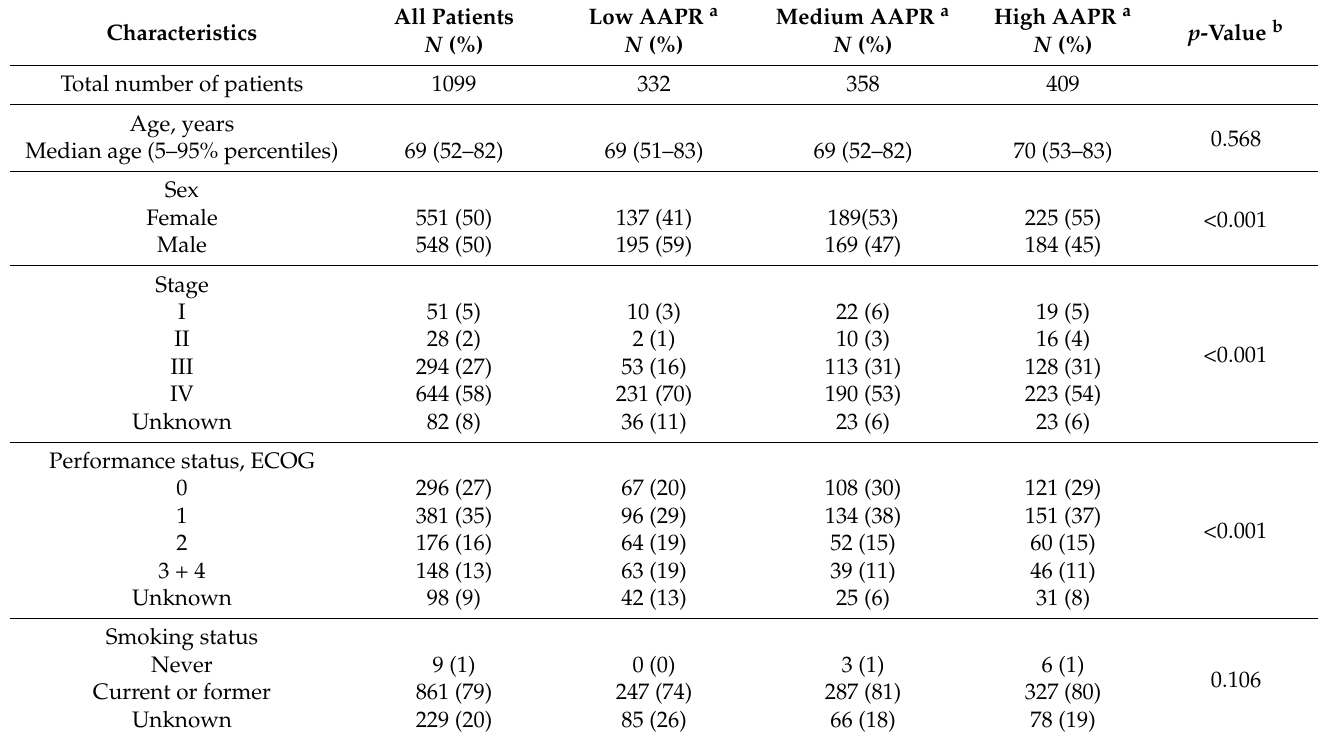
Table 4. Patient characteristics in small cell lung cancer patients stratified by albumin-to-alkaline phosphatase ratio at time of diagnosis ( N =